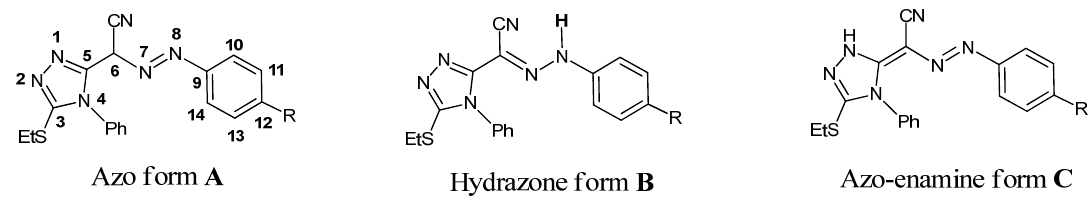
Figure 1. Three tautomeric structures of diazonium coupling product of 1 .